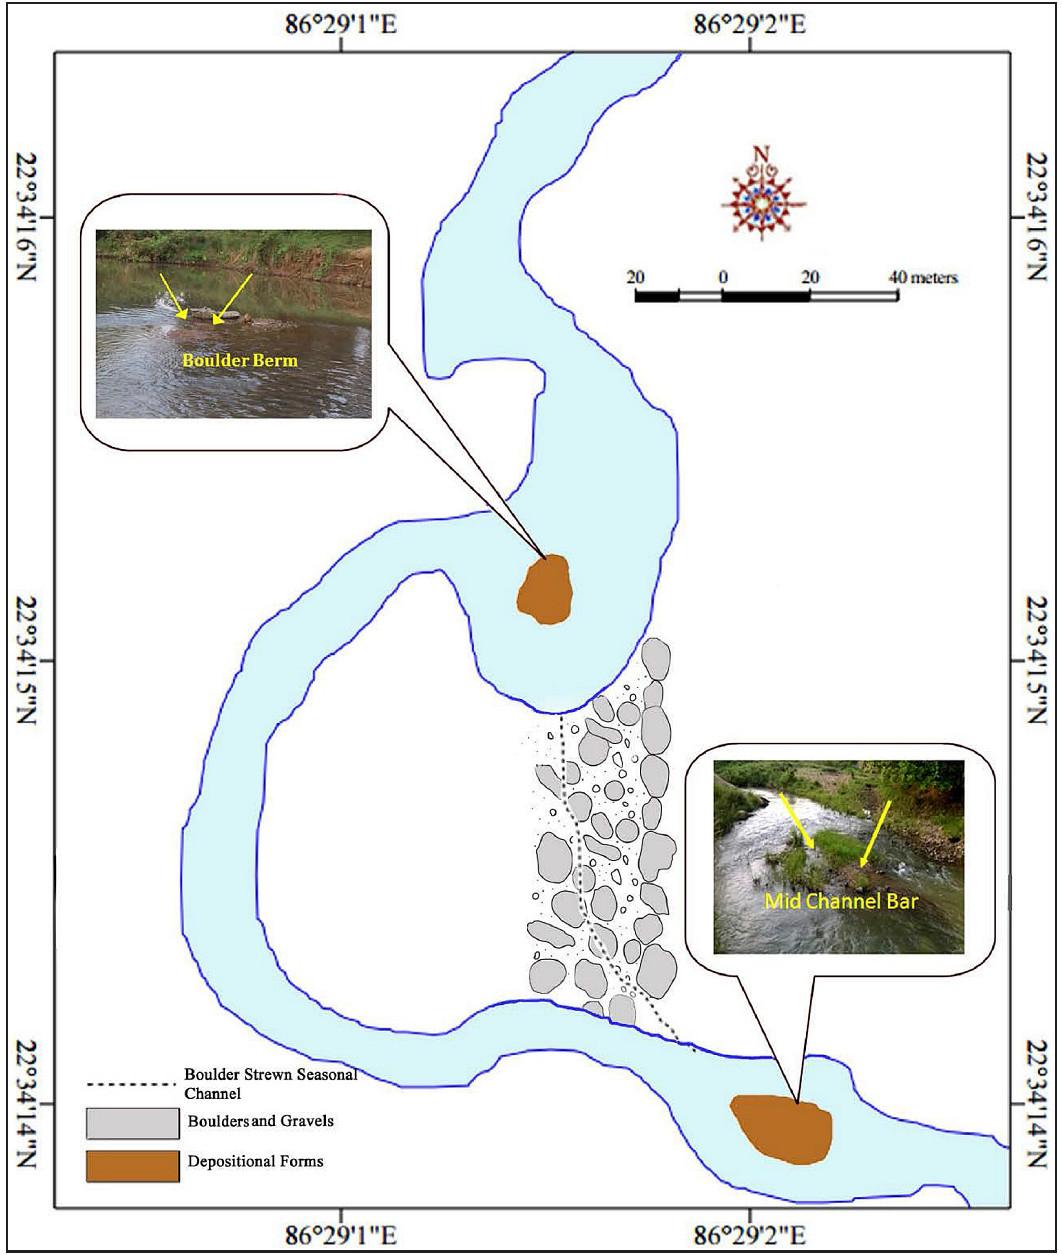
Fig. 10. In-channel forms of Upper